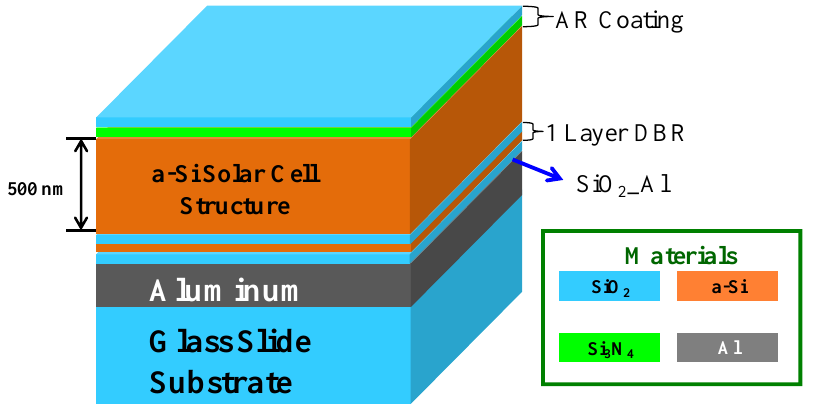
phase matching layer 2